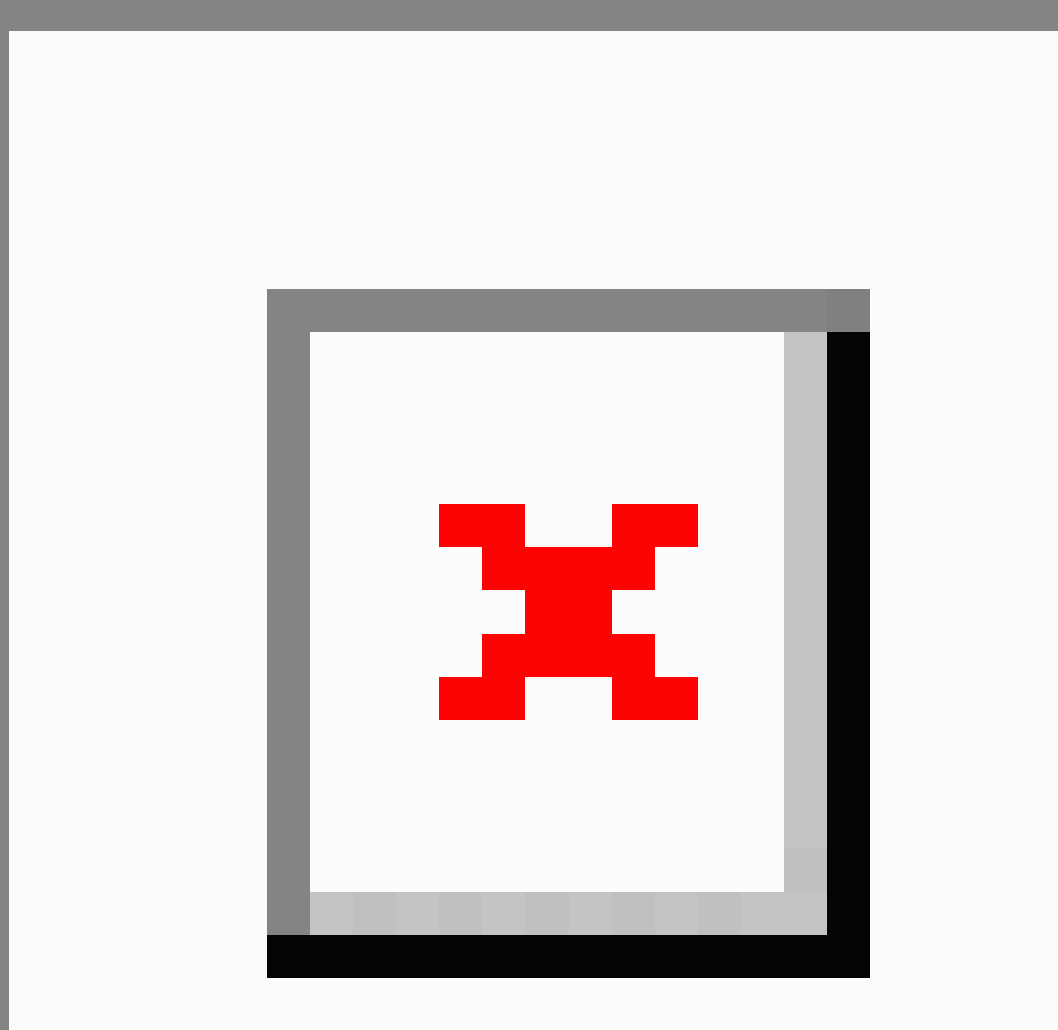
Figure 3. Factorial analysis of physicians by sociodemographic and medical characteristics, and their answers to 53 questions concerning eHealth: searching for information on the internet and social media, collection of digitized personal information and telemedecine, and mHealth apps and connected objects for